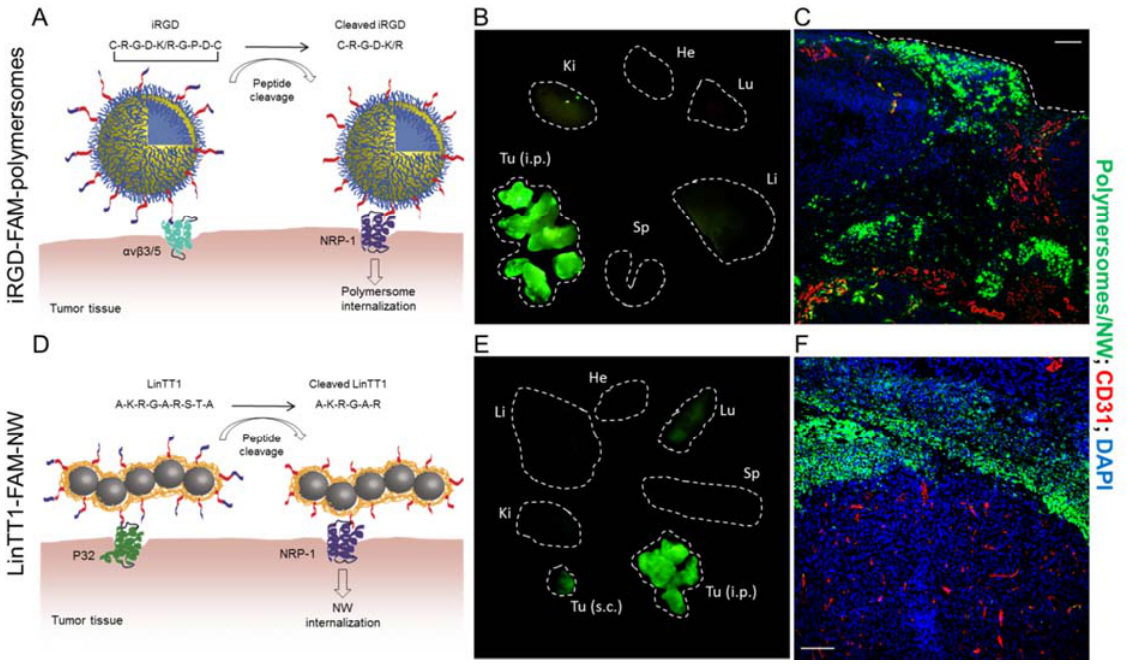
Figure 2. Intraperitoneal (IP) tumor homing and penetration of tumor penetrating CendR (C-end Rule) peptide-targeted nanosystems. ( A ) Schematic representation of fluorescein labeled iRGD-targeting polymersomes (iRGD-FAM-polymersomes) and mechanism of tumor targeting and penetration. pH-sensitive polymersomes made of the copolymer poly(oligoethylene glycol methacrylate)-poly(2-(diisopropylamino)ethyl methacrylate) (POEGMA-PDPA) were functionalized with the iRGD CendR peptide. iRGD on polymersome surface binds to α v β 3/5 integrins in the tumor blood vessels via the RGD motive. Upon cell surface recruitment, iRGD is proteolytically processed to expose C-terminally the CendR motif (CRGDK/R) and allow binding to NRP-1 in the tumor tissue. The NRP-1 binding triggers the penetration of the peptide together with the drug-loaded polymersomes into the cells and through tumor tissue. ( B ) PC homing of iRGD-FAM-polymersomes. MKN45-P bearing mouse was injected IP with 20 mg polymer/Kg, perfused 24 h later, and excised organs were subjected to fluorescence imaging ex vivo. ( C ) Confocal microscopy of the peritoneal MKN45-P tumor tissue collected 24 h after IP injection of iRGD-FAM-polymersomes. Green = polymersomes; red = CD21; blue = DAPI. Scale bar: 100 µm. ( D ) Schematic representation of fluorescein-labeled LinTT1-targeted iron oxide nanoworms (LinTT1-FAM-NW). Dextran-coated iron oxide nanoworms (NWs) were functionalized with the CendR peptide LinTT1. LinTT1 on the nanoworms is recruited to p32 receptor on the surface of tumor cells. LinTT1 is cleaved by the tumor related enzyme urokinase plasminogen activator (uPA), exposing the CendR motif (AKRGAR) that binds to neuropilin-1 (NRP-1) and triggers the internalization of the peptide and the attached NW into tumor tissue. ( E ) Ex vivo images showing the specific homing of LinTT1-FAM-NW. MKN45-P bearing mouse was injected IP with 5 mg iron/Kg and perfused 5 h later. ( F ) Confocal microscopy images of the peritoneal MKN45-P tumor tissue 5 h after IP injection of LinTT1-FAM-NW. Green = NWs; red = CD21; blue = DAPI. Overexpression of iRGD receptors (integrins and NRP-1) in malignant tissues and the ability of iRGD to directly penetrate tumors using non-vascular route [58,59], make iRGD well suited for IP precision delivery. In the MKN-45P gastric PC xenograft model, IP-administered iRGD potentiated the tumor penetration and the anticancer activity of coadministered free doxorubicin [39]. iRGD coadministration potentiated tumor accumulation of doxorubicin ~2.5 fold, whereas it had no effect in the normal organs. iRGD effect on tumor accumulation and penetration of doxorubicin